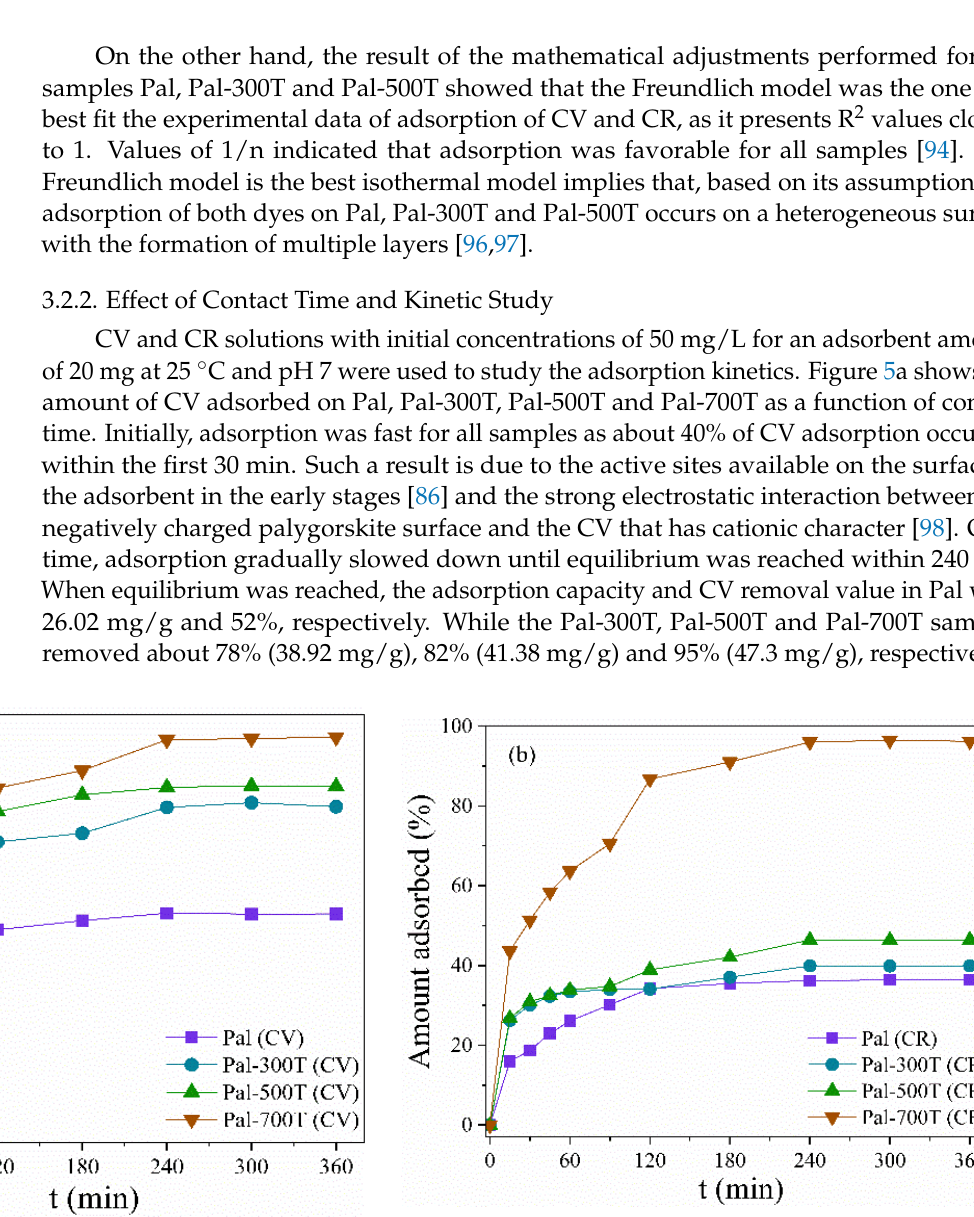
Figure 5. Effect of contact time on the adsorption of ( a ) CV and ( b ) CR in palygorskite before and after heat treatment.